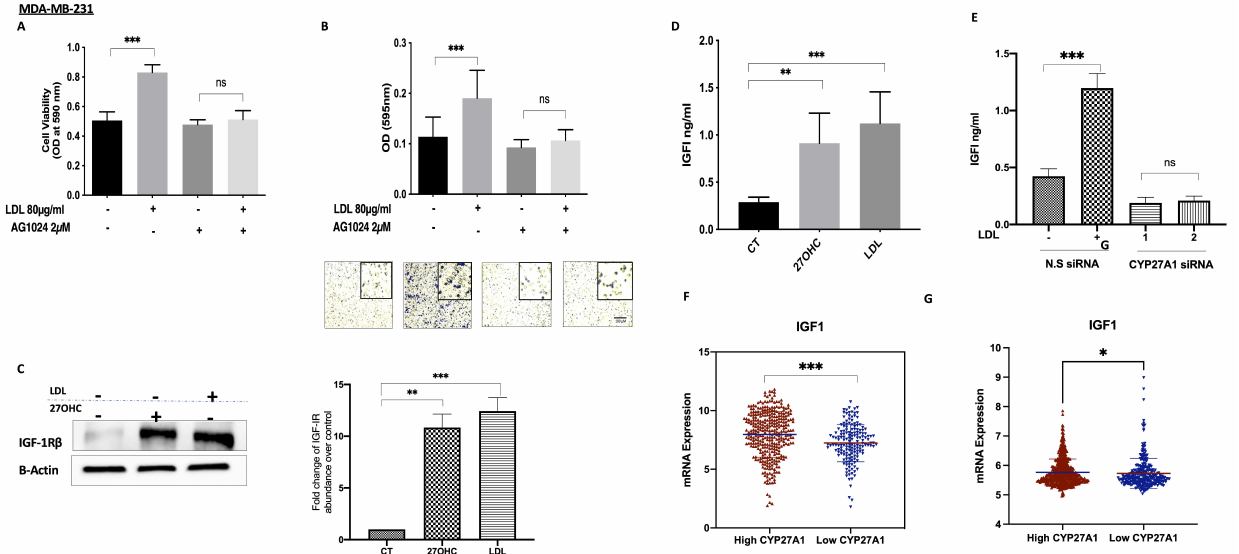
Figure 5. Interactions between the IGF system and cholesterol metabolism in TNBC. Cell proliferation for ( A ) MDA-MB-231 treated with (LDL 80 µ g/mL) in the presence or absence of a tyrosine kinase inhibitor (AG1024; 2 µ M) for 48 h, assessed using a crystal violet proliferation assay. Cell migration for ( B ) MDA-MB-231 cells after being dosed with LDL with or without AG1024 (2 µ M). The migrated cells were stained with crystal violet, and images were taken ( × 20 magnification). Western blotting results for ( C ) MDA-MB-231 after being dosed with 27OHC (0.1 µ M) and LDL (80 µ g/mL) for 48 h; their densitometry analyses of fold changes of IGF-IR β against loading control β -actin. A radioimmunoassay was used to measure IGF-I concentrations in ( D ) MDA-MB-231 cells after being dosed with 27OHC (0.1 µ M) and LDL (80 µ g/mL) for 48 h, as well as ( E ) levels of IGF1 in the presence or absence of CYP27A1 in MDA-MB-231 after being dosed with LDL in the presence or absence of CYP27A1 for 48 h. ( F ) Scatterplot analysis of the TCGA data of 504 invasive breast cancer carcinomas for the mRNA expression of IGF-I represented as the median expression of CYP27A1. ( G ) Scatterplot analysis of the METABRIC data of 1193 invasive breast cancer carcinomas for the mRNA expression of IGF-I represented as the median expression of CYP27A1. Data representative of mean ± SEM ( n = 3). p -values were determined by using the one-way statistical analysis of GraphPad Prism: ANOVA test plus least significant difference (LSD) post-hoc test (* p <0.05, ** p < 0.01, *** p <0.001) ( A – F ); ( G ) Mann–Whitney test. Scale bar represents 100 µ